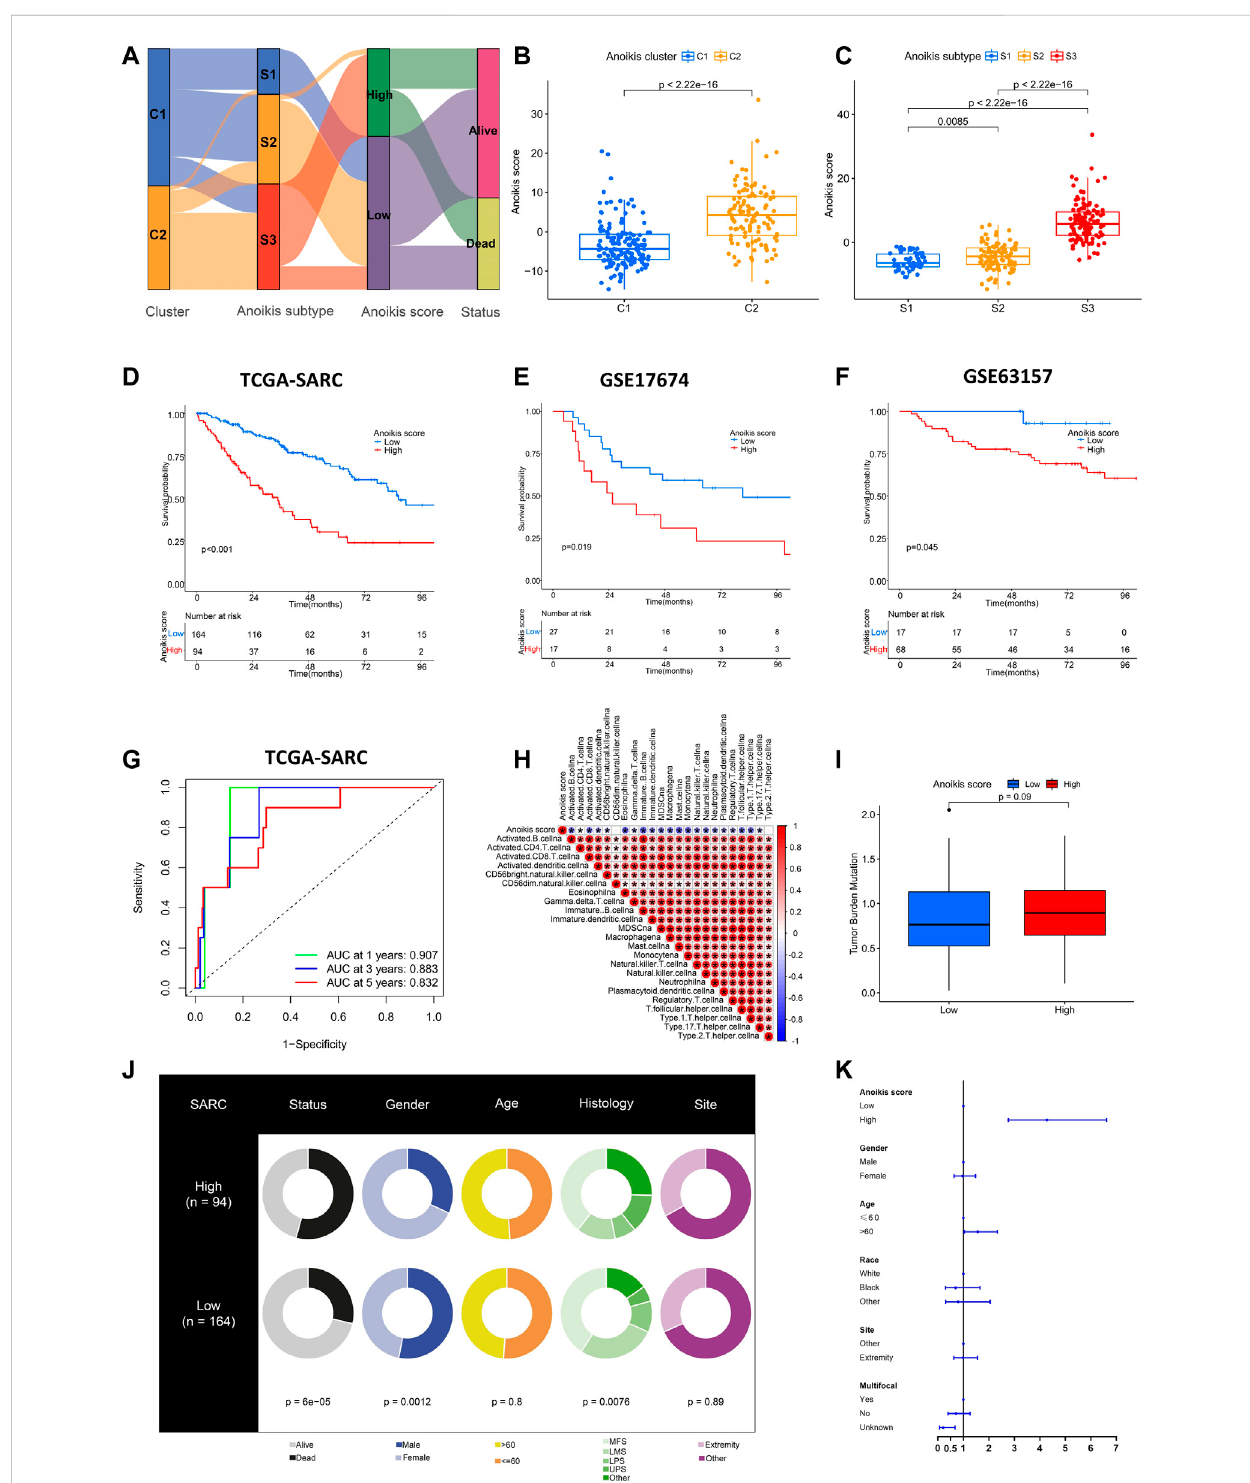
FIGURE 6 Establishment and validation of Anoikis score. (A) Alluvial diagram showing the relations among Anoikis clusters, Anoikis subtypes and Anoikis score groups. (B, C) The box plots illustrating the Anoikis score in different Anoikis clusters and Anoikis subtypes. (D – F) The Kaplan-Meier curves comparing the survival between low (blue) and high (red) Anoikis score groups in TCGA-SARC cohort (D) , GSE17674 (E) and GSE63157 (F) . (G) The time-dependent receiver operating characteristic curve (ROC) assessing the predictive performance of Anoikis score in TCGA-SARC cohort. (H) The correlation analysis between Anoikis score and signatures of immune cells. Red indicated positively associated and blue indicated negatively associated. (I) The box plot of tumor mutation burden (TMB) between low and high Anoikis score groups in TCGA-SARC cohort. (J) The pie plots showing proportions of different clinical characteristics between low and high Anoikis score groups in TCGA-SARC cohort. (K) The forest plot illustration multi-variate Cox analysis including clinical information and Anoikis score. *, p <